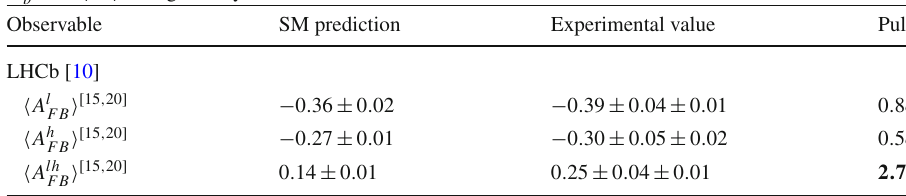
→ Λμ + μ − included in of Λ 0 b the global fit